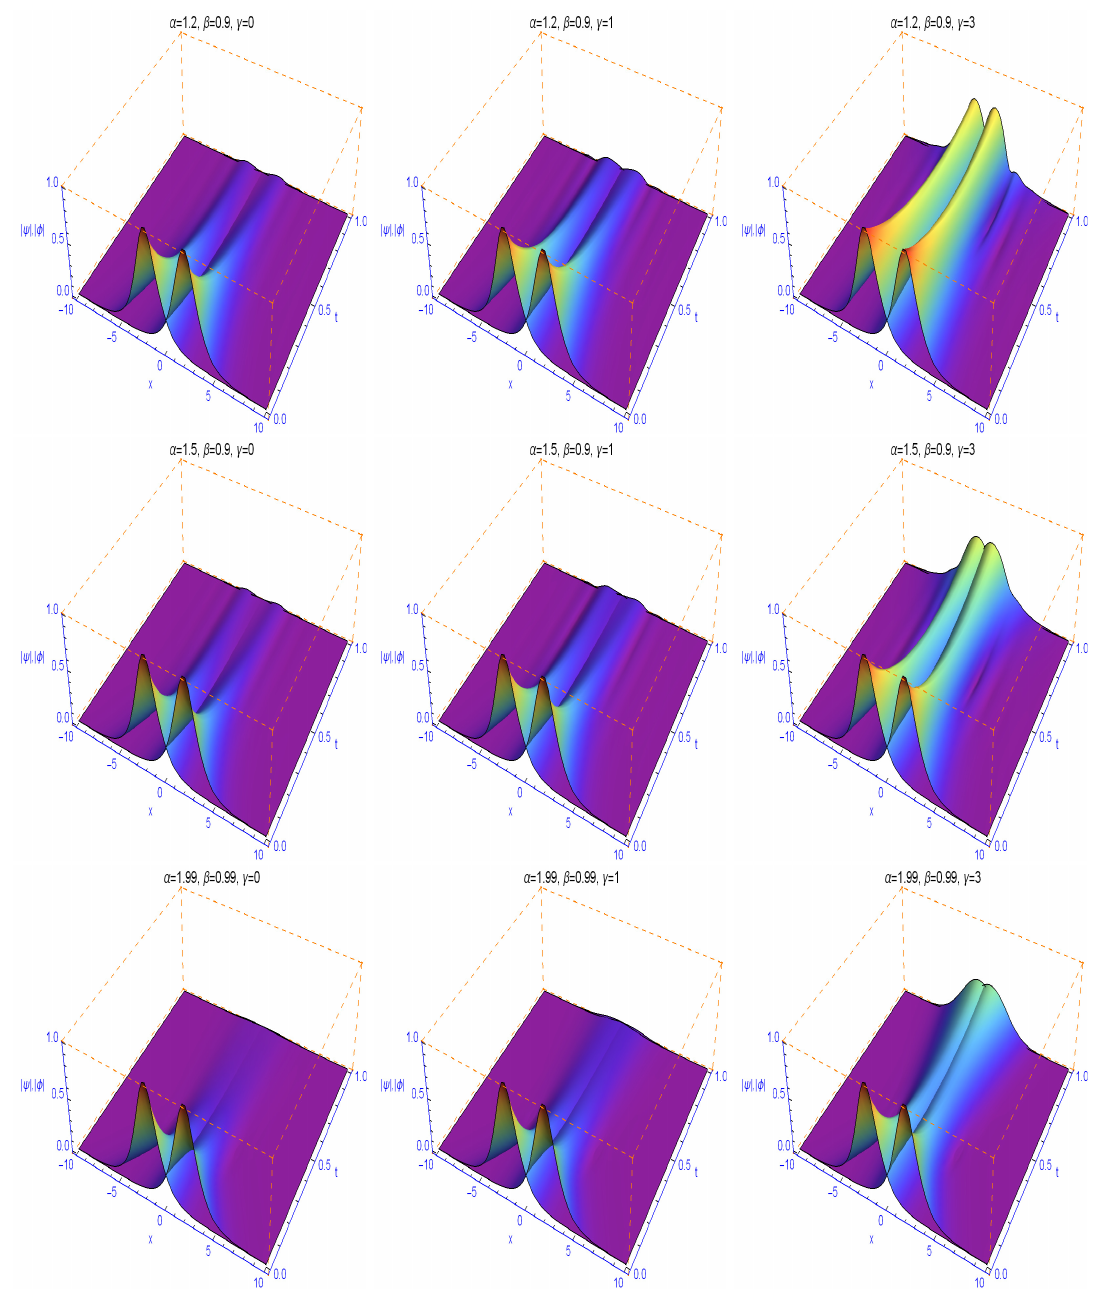
Figure 3. The evolution of | ψ N | and | φ N | for different values of γ 1 = γ 2 = γ = 0,1,3. The first row is presented at α = 1.2 and β = 0.9. The second row is presented at α = 1.5 and β = 0.9. The third row is done at α = 1.99 and β =